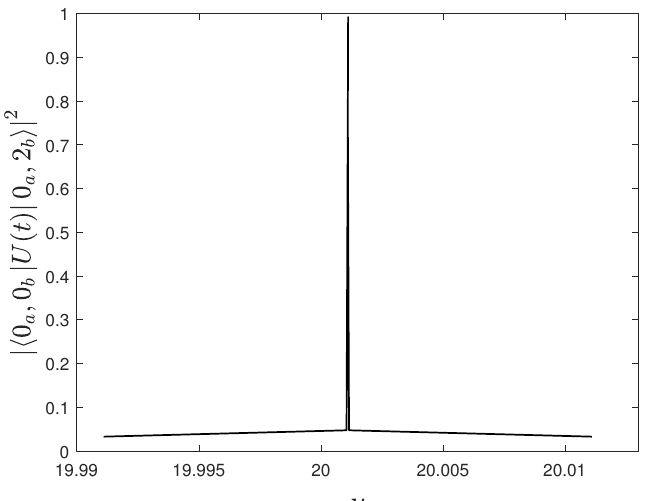
2 as a function of the modulation U ( t ) 0 a ,0 b 0 a ,2 b |(cid:104) | | (cid:105)| 2 ω b , ω b = 10, ω a = ω b /2, ≈